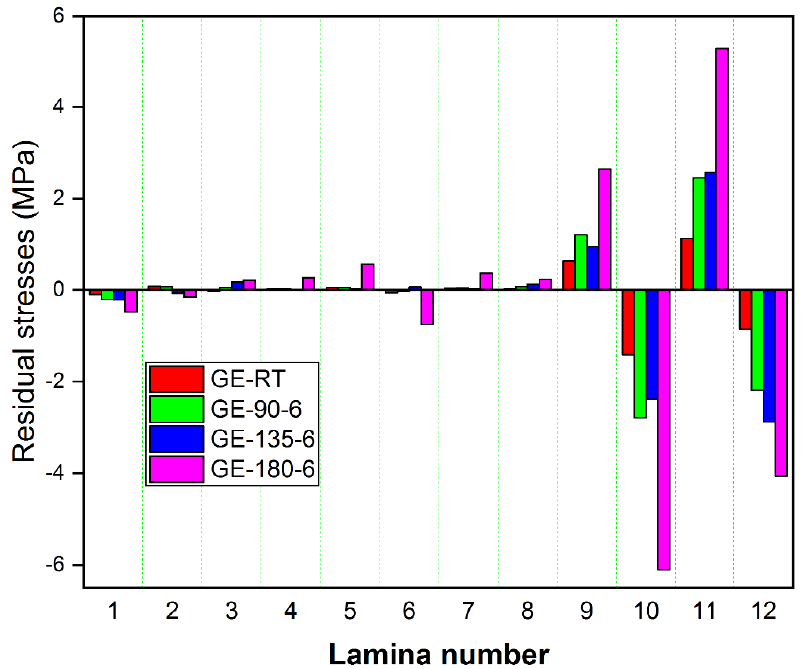
Figure 5. Transverse residual stress in each lamina determined from recorded transverse strains for all GE laminates.